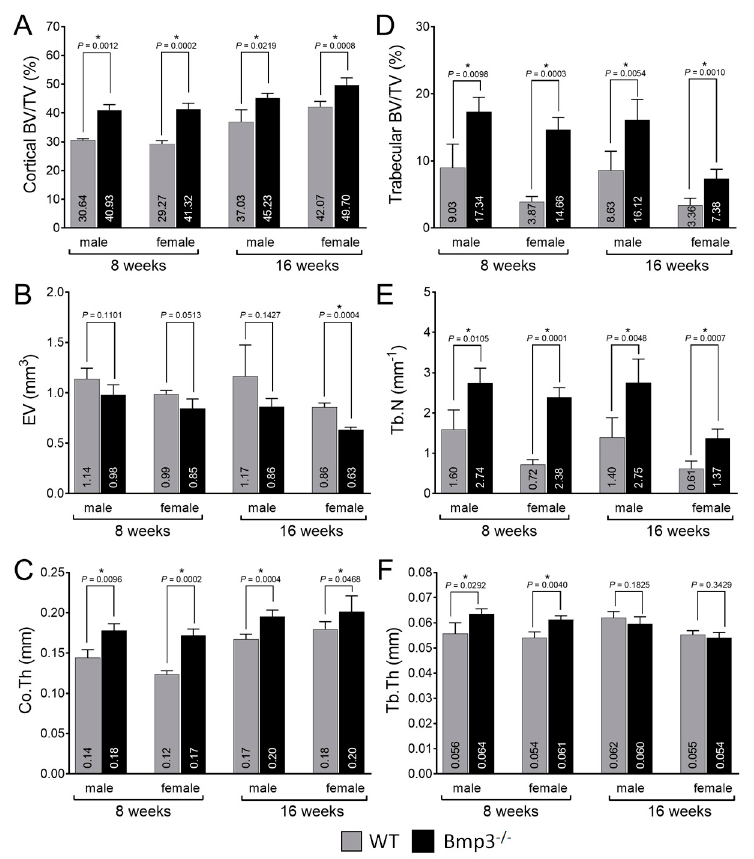
Figure 3. Morphometric analysis of the distal femur of Bmp3 − / − and WT mice at 8 and 16 weeks of age. ( A ) BV/T, ( B ) EV and ( C ) Co.Th for femoral cortical bone. ( D ) BV/TV, ( E ) Th.N and ( F ) Tb.Th for femoral trabecular bone. Statistically significant differences are indicated by